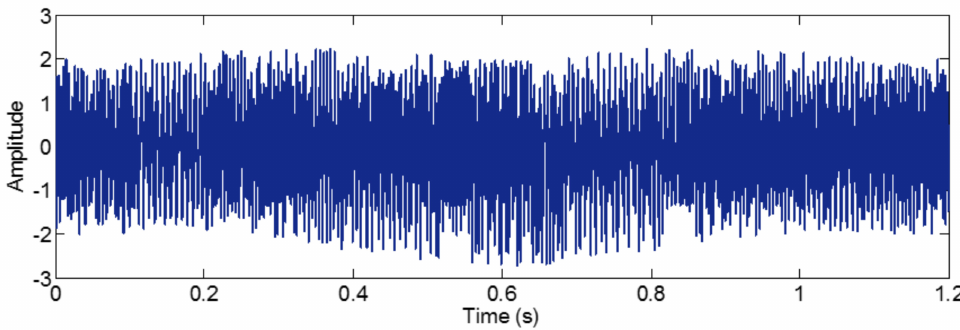
Figure 42. The waveform of the sample signal f sig 9